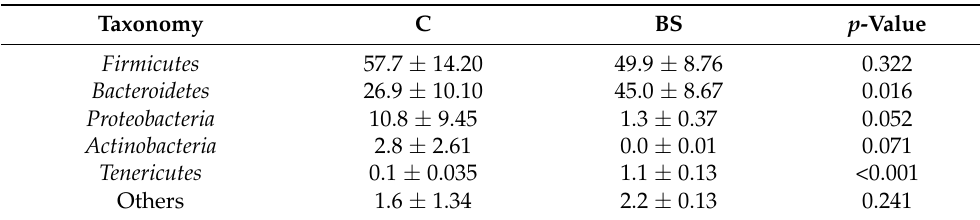
Table 4. Abundance (mean ± SE; n = 5; >1%) at phylum level of bacteria in the rumen fluid of lambs fed basal diet only (Control; C) or basal diet supplemented with Bacillus subtilis at the concentration of 3 × 10 8 CFU/kg DM